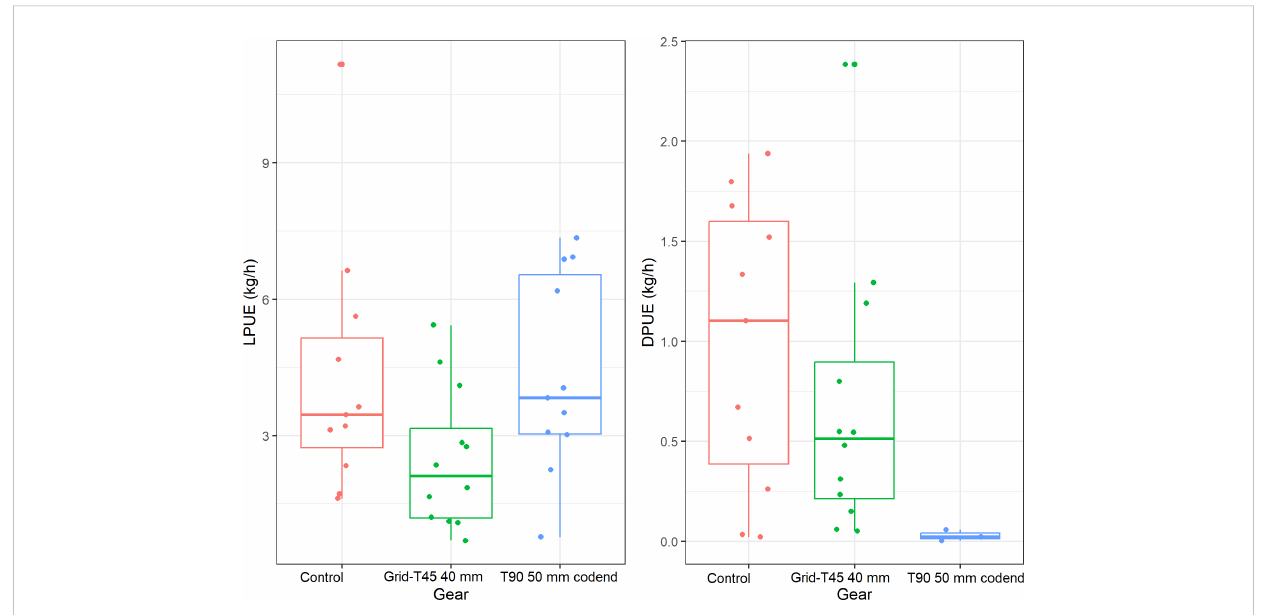
FIGURE 4 Boxplots of Merluccius merluccius (herein HKE) catch rates (kg/h) per gear caught during the campaign classi fi ed in landing per unit effort (LPUE; commercial) – left – and discard per unit effort (DPUE; discard) – right – according to the minimum conservation reference size (MCRS) established by the Reg. EU